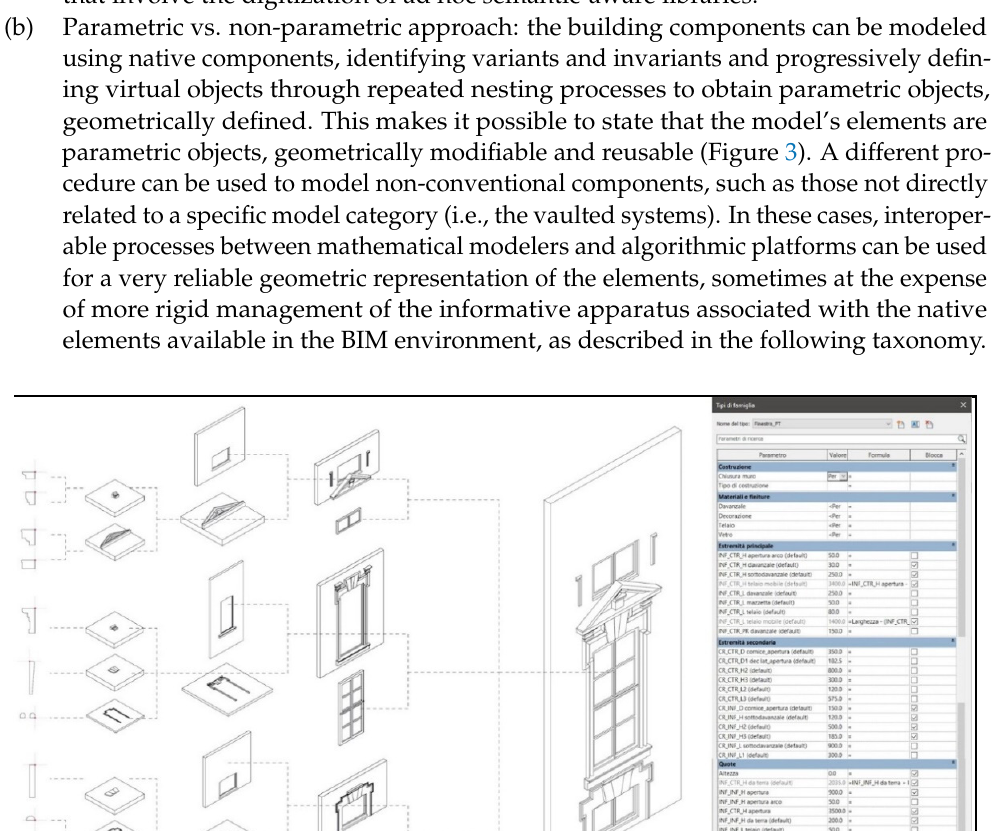
Figure 2. Internal facade of the Collegio dei Nobili. Image by the authors.